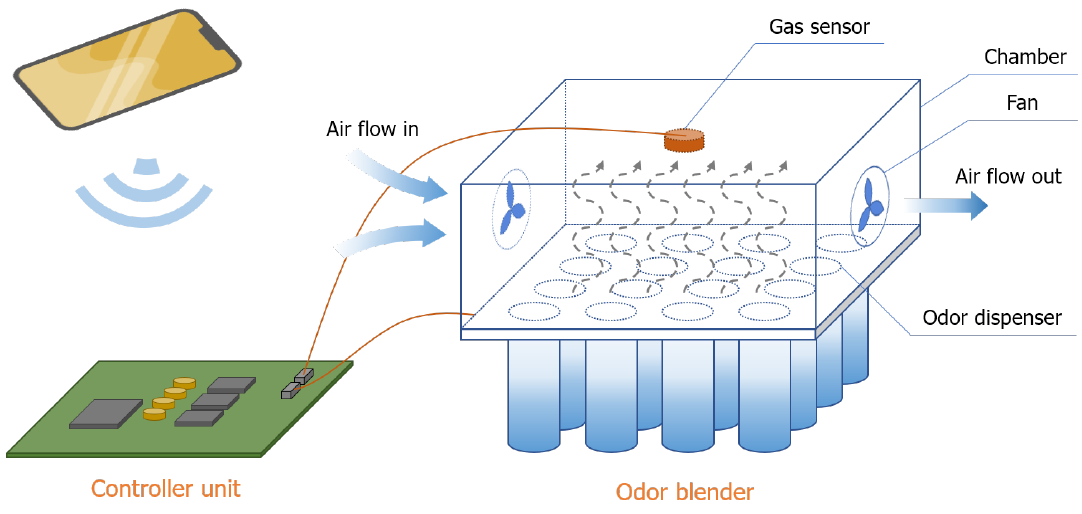
Figure 1. Structural schematic of the odor reproduction